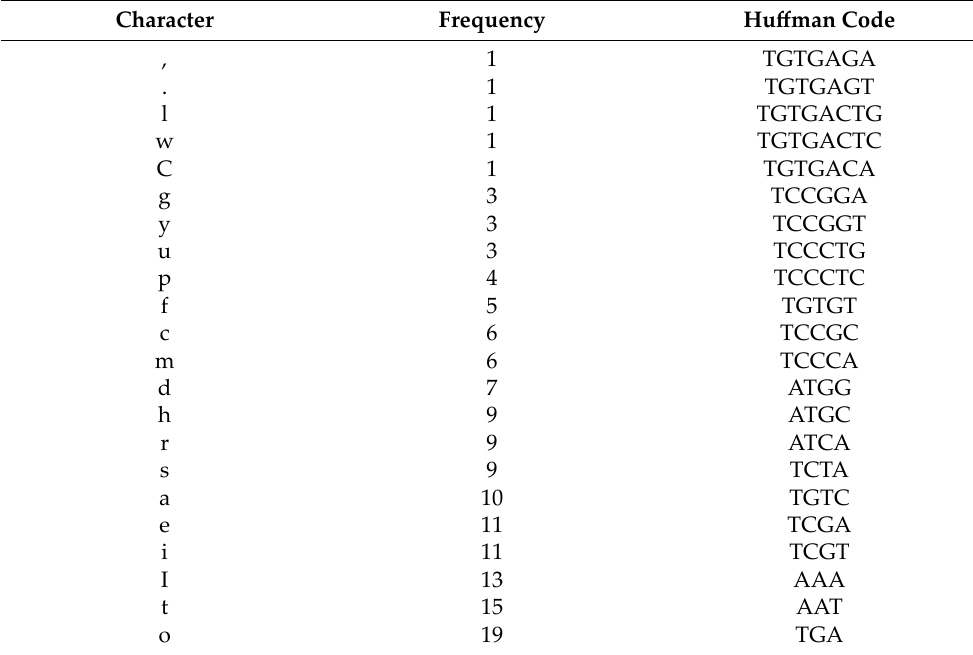
Table 4. Corresponding Huffman Codes for each symbol of the Original